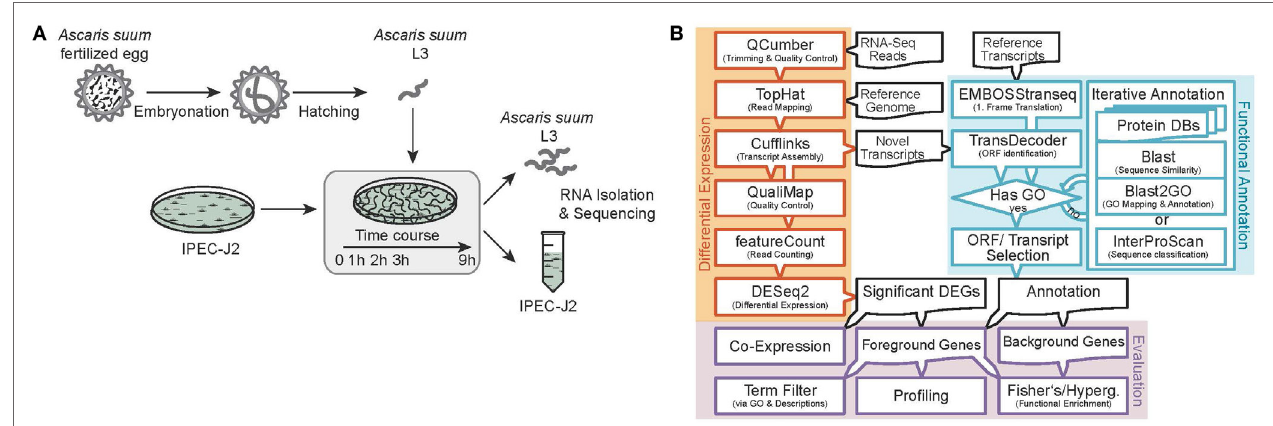
FigUre 1 | Experimental design and RNA-Seq data processing. (a) Analysis of the early host–parasite interaction of Ascaris suum L3 and porcine epithelial cells (IPEC-J2) by studying dual-species gene expression dynamics over a time course (0–9 h). (B) Paired RNA samples were Illumina sequenced, preprocessed, mapped to reference genomes, annotated, and differential gene expression and functional analysis was performed using the illustrated bioinformatics